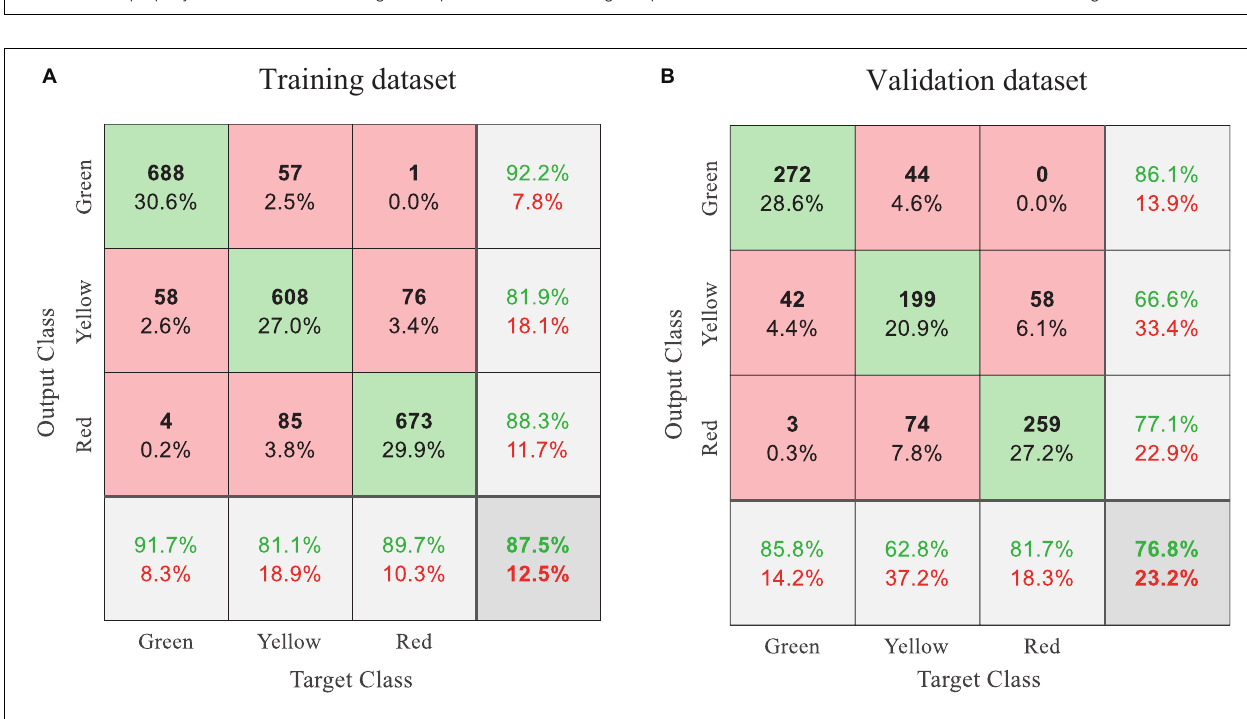
FIGURE 5 | Classification results summarized in confusion matrices for: (A) the training dataset; (B) the validation dataset.